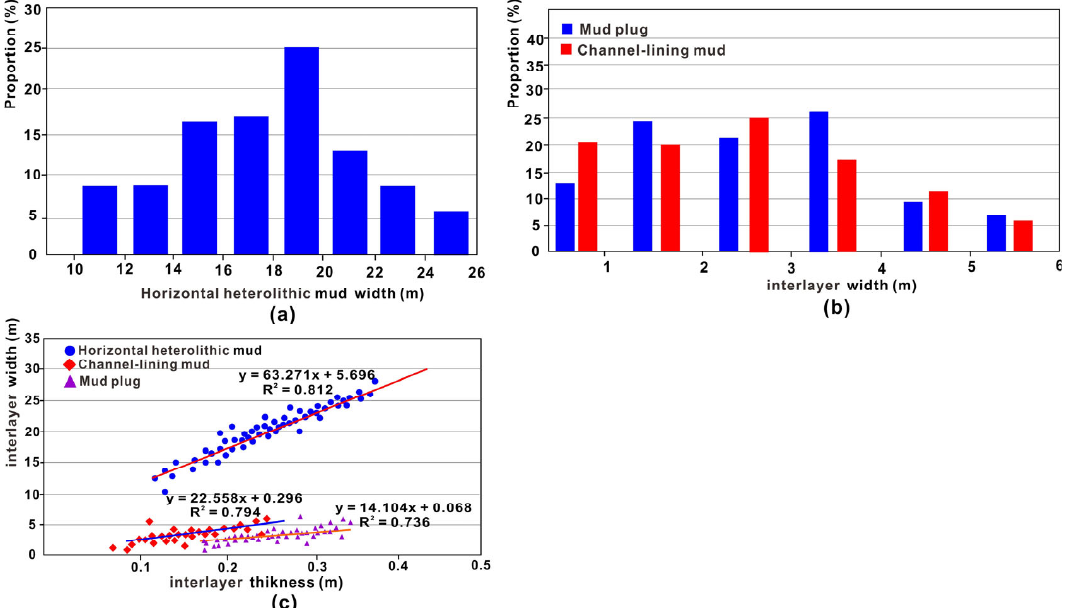
Figure 6. ( a ) Frequency distribution histogram of horizontal heterolithic mud width. ( b ) Frequency distribution histogram of mud plug and channel ‐ lining mud width. ( c ) Relationship between width distribution histogram of mud plug and channel-lining mud width. ( c ) Relationship between width and thickness of different types of interlayers in braided reservoir. and thickness of different types of interlayers in braided